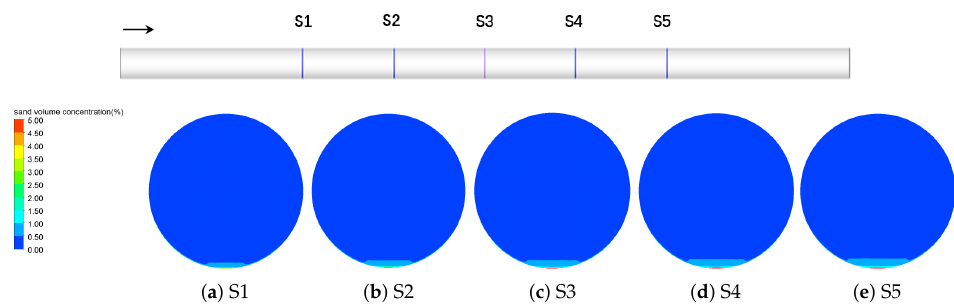
Figure 11. Liquid velocity at different cross-sections (inflow velocity = 0.4 m/s).